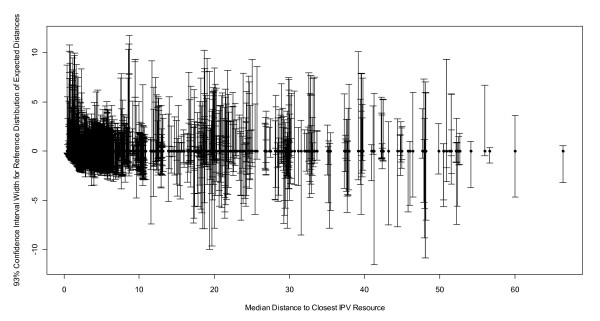
Width of the 93% confidence interval increases with median distance to closest IPV resource (PSM method).